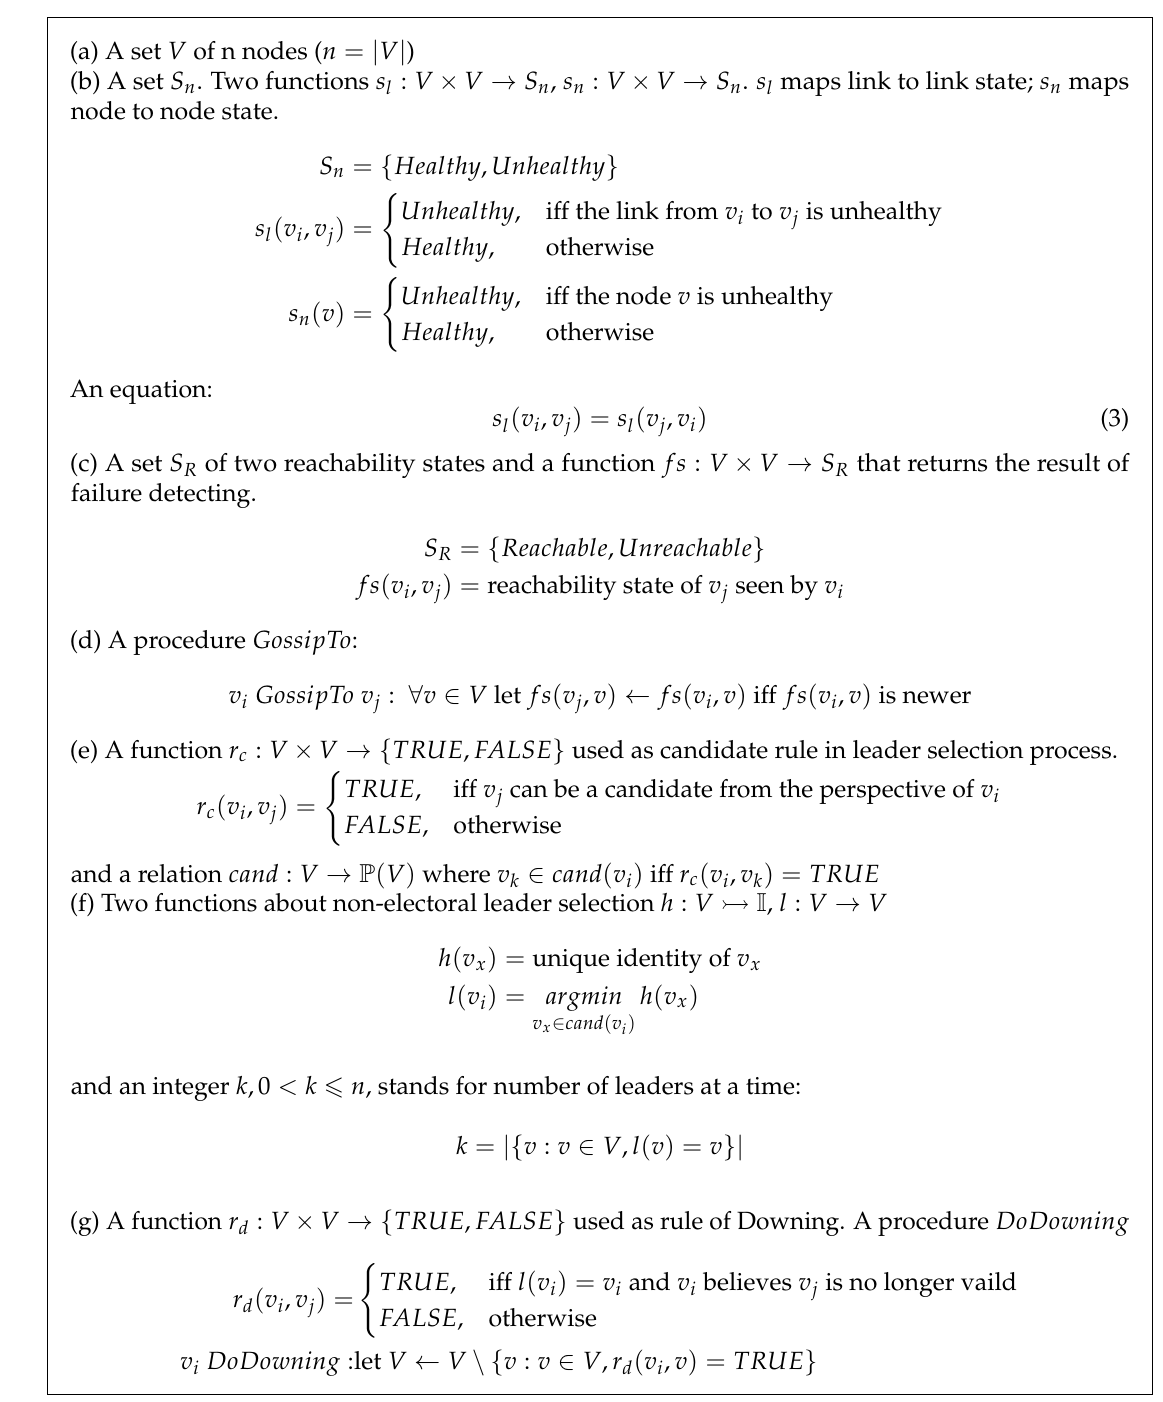
Table 1. Formal system